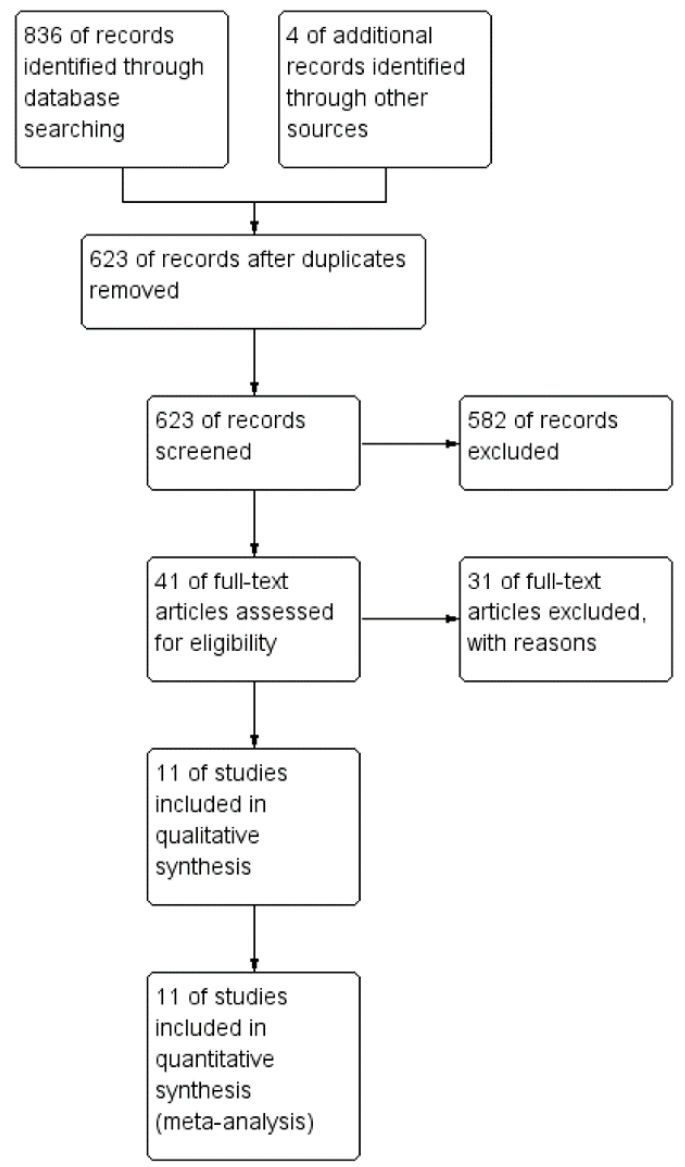
Figure 1. Preferred Reporting Items for Systematic reviews (PRISMA) Flowchart.